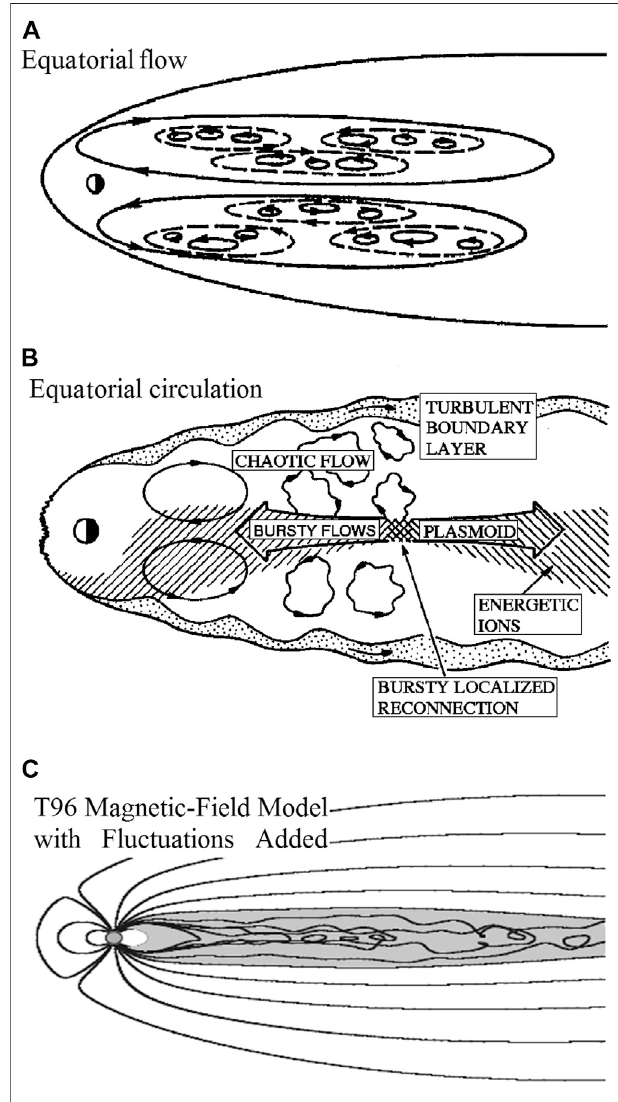
FIGURE 2 | Early schemes of the plasma sheet turbulent fl ows at the equatorial plane of (A) Antonova (1985), (B) Kennel (1995) and in the meridian cross section (C) Borovsky and Funsten